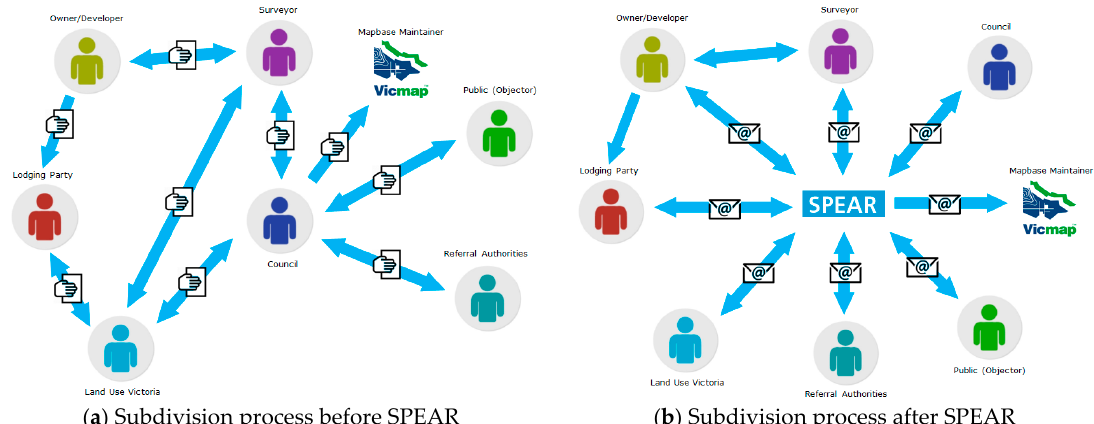
Figure 1. Victorian cadastral information (paper → digital).